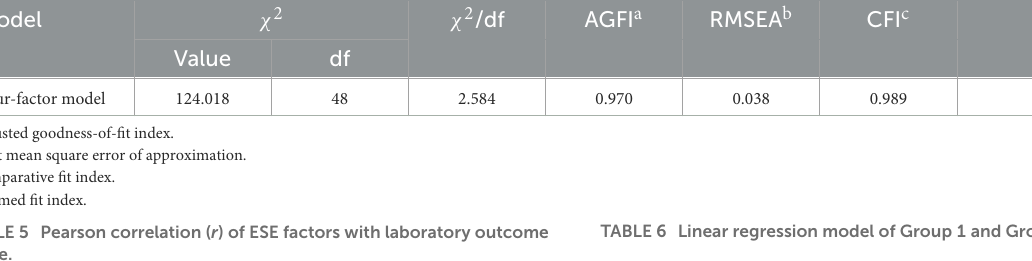
TABLE 6 Linear regression model of Group 1 and Group